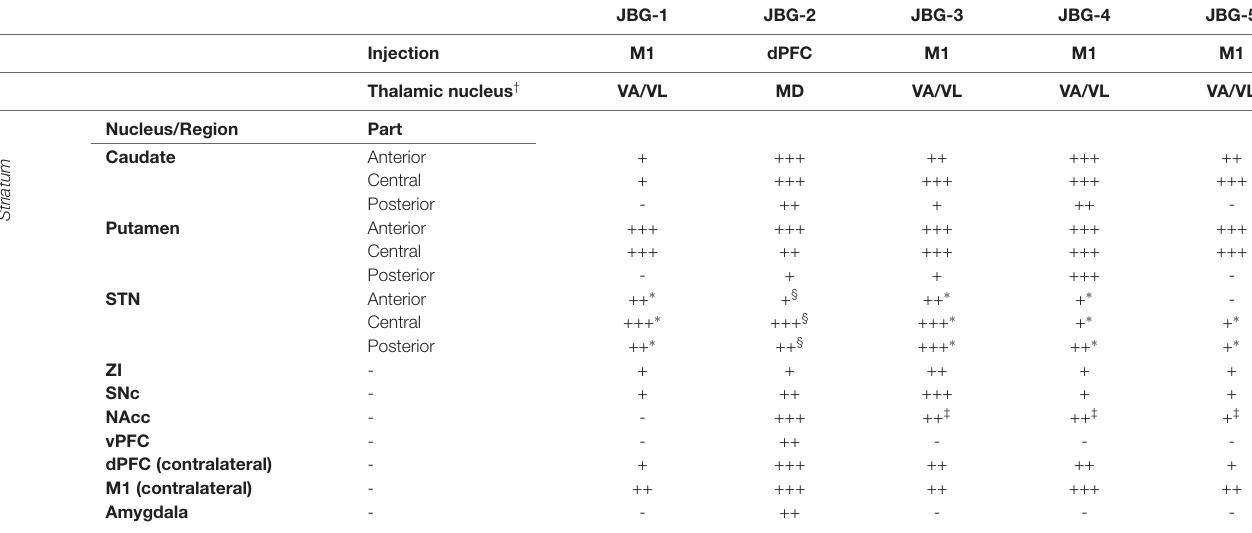
TABLE 1 | Schematic summary of the neuronal tracing found across different regions or